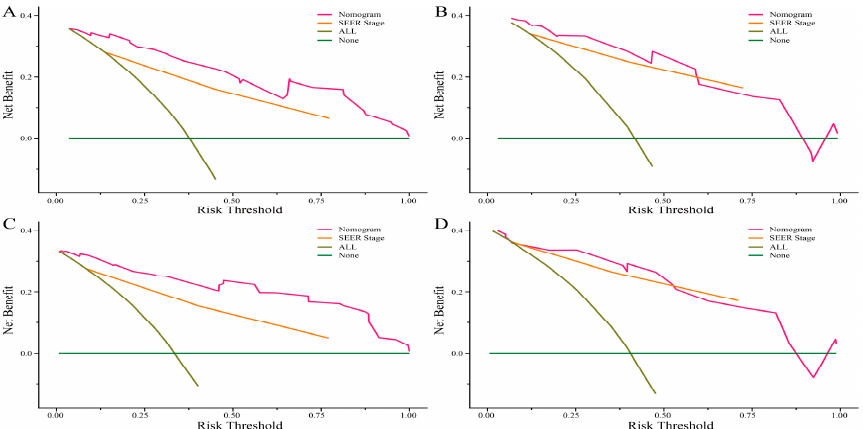
Figure 6. Decision curve analysis (DCA) of the nomogram and SEER stage system for the overall survival (OS) and cancer-specific survival (CSS) prediction of patients with neuroendocrine neoplasms of the gallbladder undergoing primary tumor resection. ( A ) The training and ( B ) internal validation sets for the OS. ( C ) The training and ( D ) internal validation sets for the CSS. In external validation, we analyzed the data of GB-NEN patients who received pri- mary tumor surgery (n = 12) at Wuhan Union hospital from 2010 to 2021. The last follow- up was on November 15, 2021. Demographics and clinicopathological characteristics are shown in Table 1. Given the rarity of GB-NENs, our data of GB-NENs can only validate CSS at 6 and 12 months. In CSS analysis, the C-indexes were 0.777 (95% CI: 0.608–0.946). In addition, the AUCs of 6- and 12-month (0.972 and 0.861) nomograms were greater than the SEER stage system (0.833 and 0.833) (Figure 7). The results suggested that our predic- tion model had good applicability and predictive performance in external data.